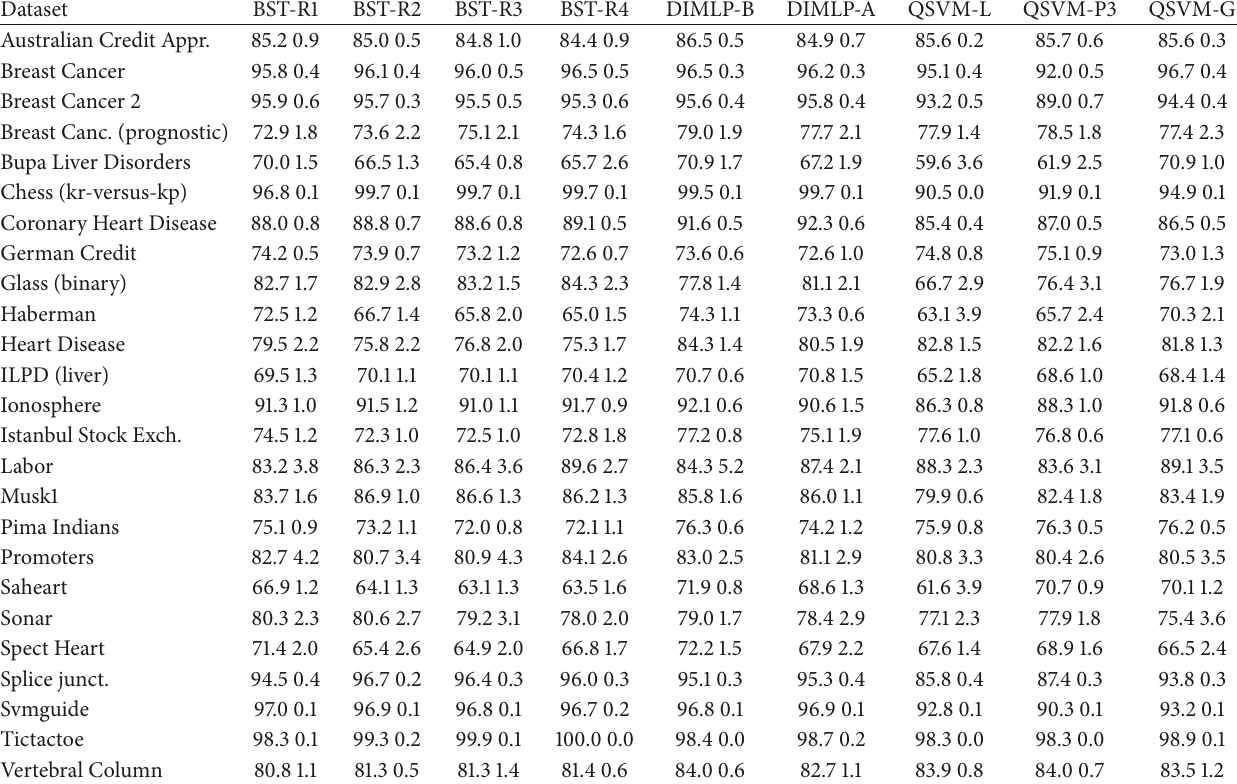
Table 5: Average predictive accuracy and standard deviations of the extracted rules for BST-R, DIMLP ensembles, and QSVMs.